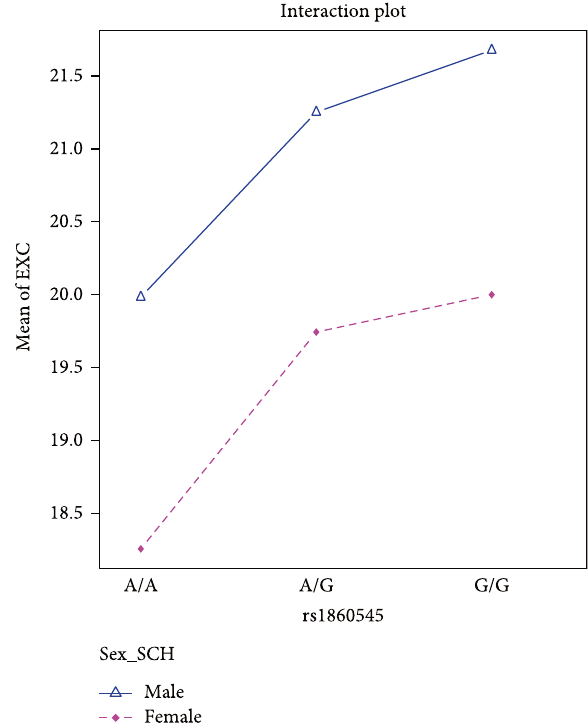
Figure 2: The results of the ANOVA analysis for rs1860545 and EXC subscale in the patient